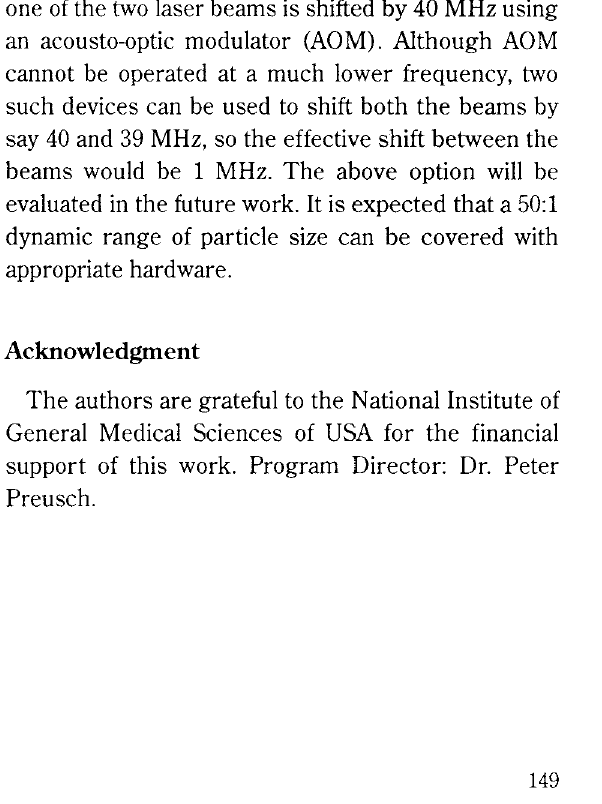
Fig. 10 Size- velocity correlations for the rounded crystals